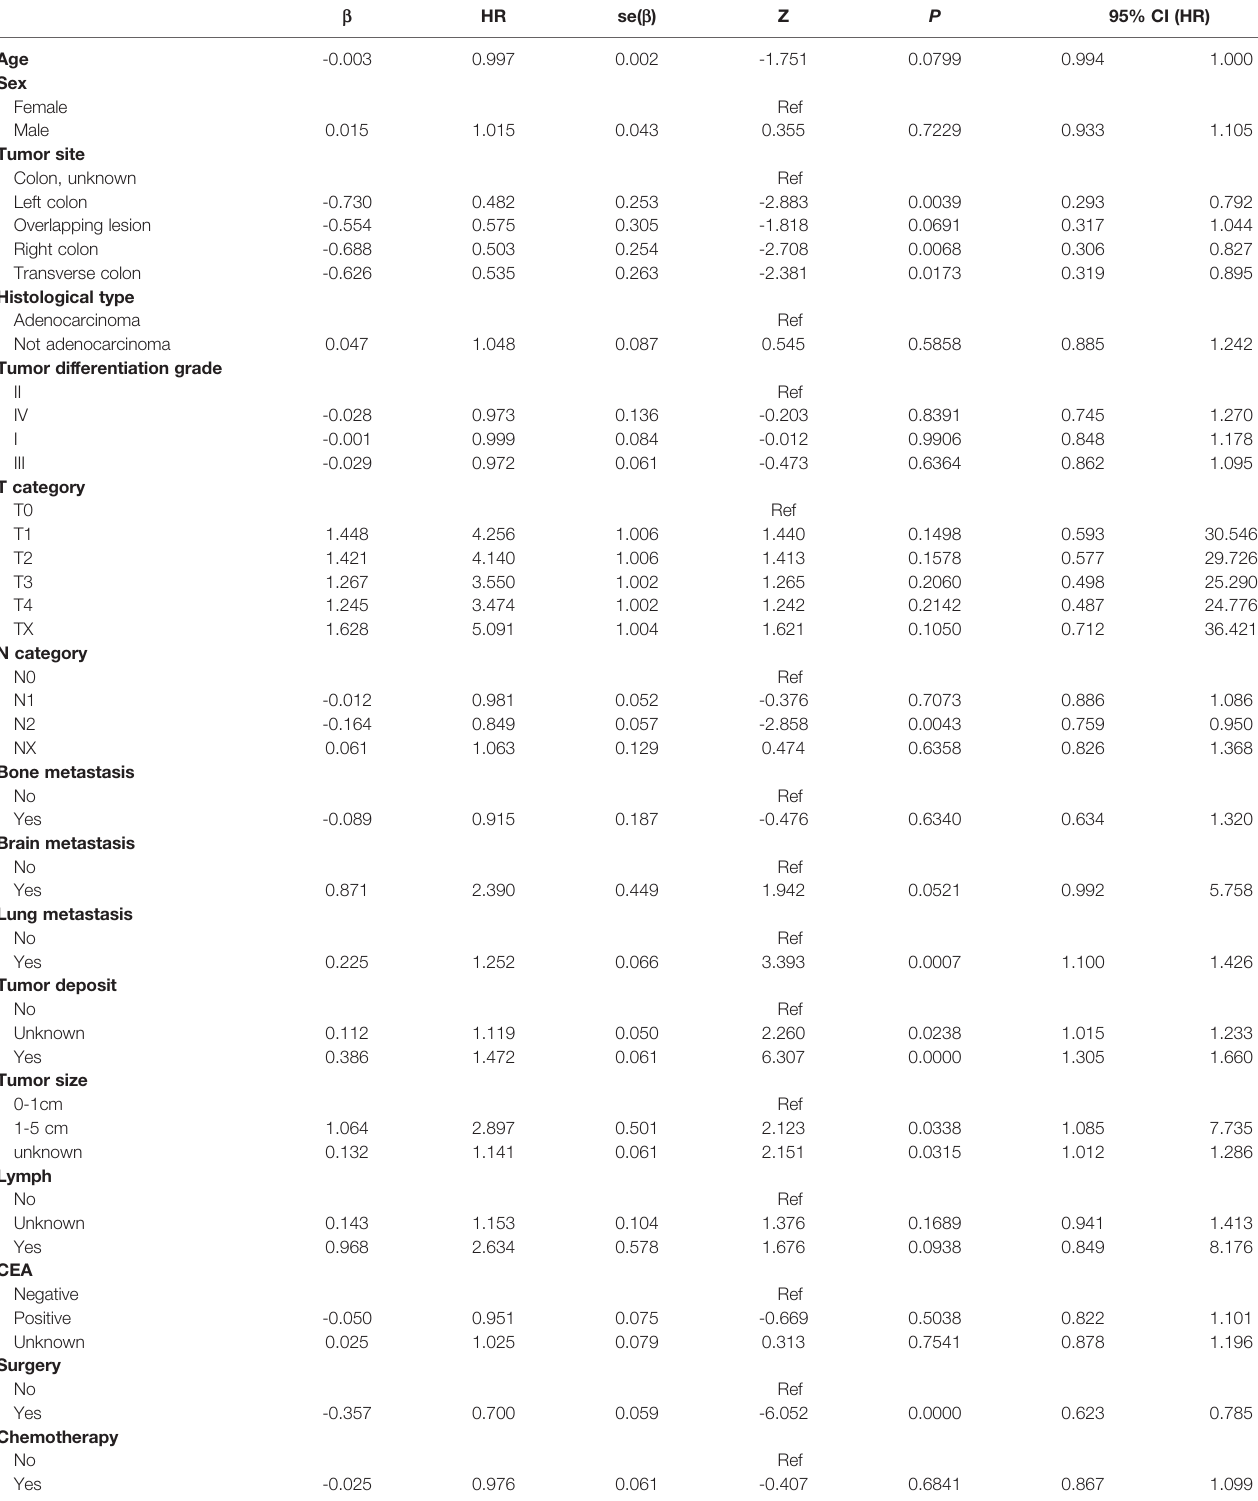
TABLE 2 | Univariate regression for